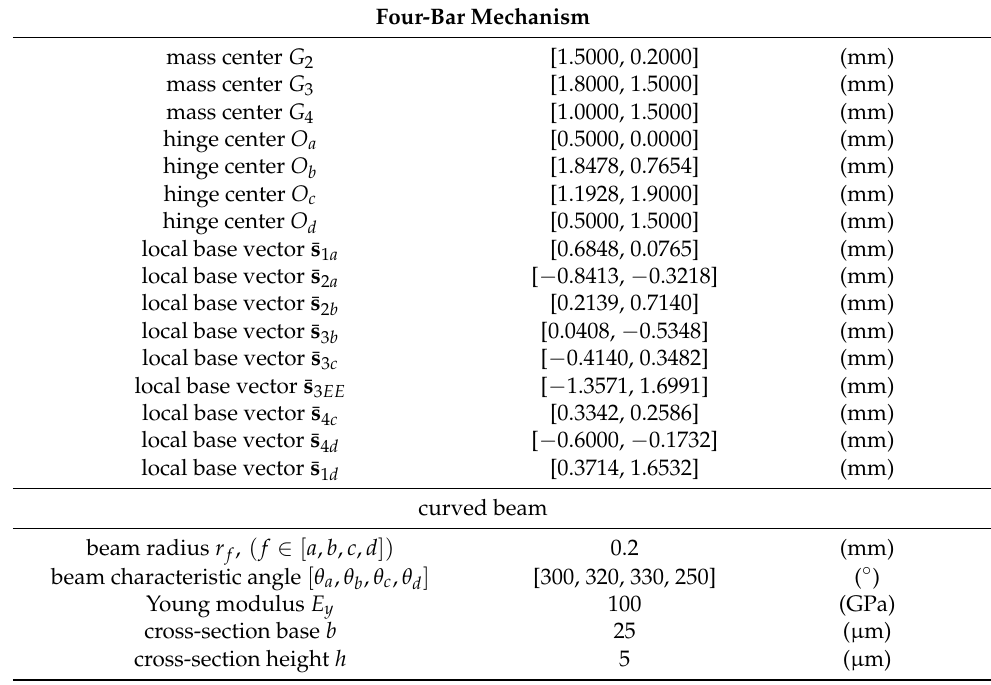
Table 1. Geometric and structural parameters of the case